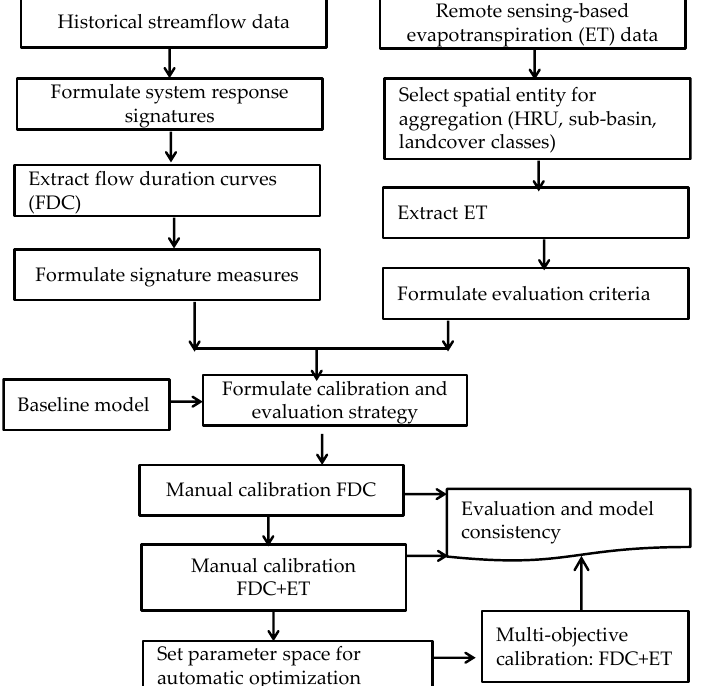
Figure 3. A schematic of the workflow used in this study.